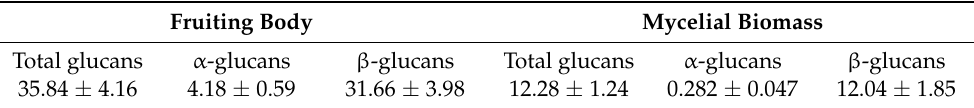
Table 1. Glucan content (%) in the fruiting body and mycelial biomass of Pleurotus ostreatus . Fruiting